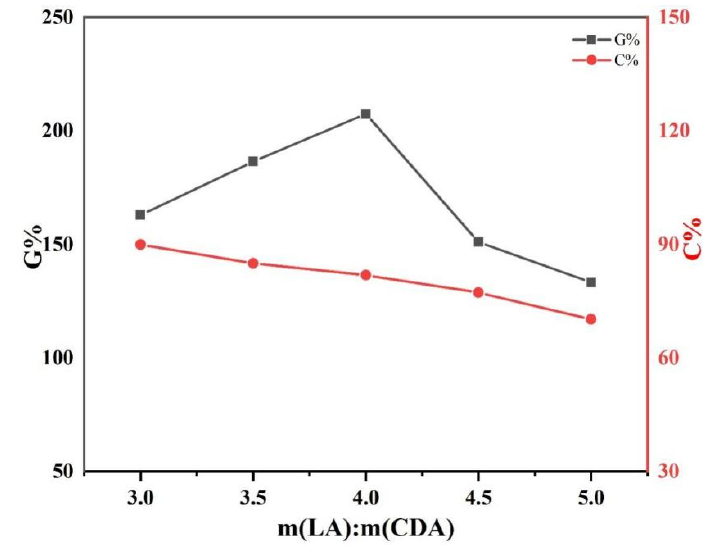
Figure 1. Grafting rate and monomer conversion rate of CDA–g–PLLA under different feeding mass ratio conditions at reaction temperatures of 130 °C for 1 h.